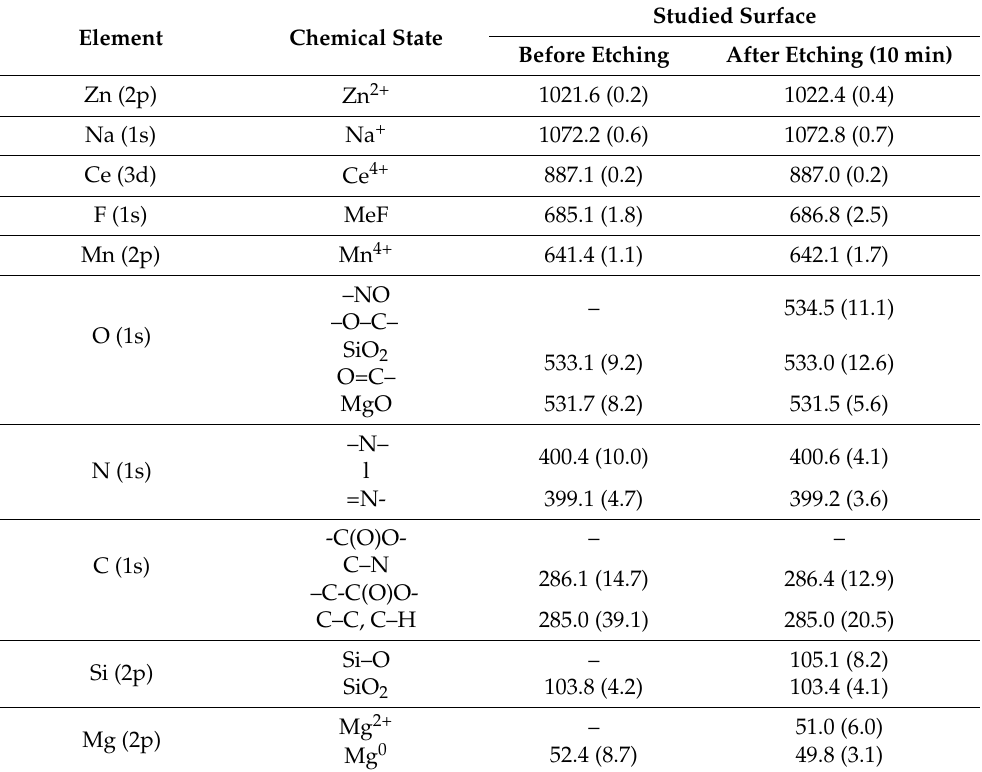
Table 2. Binding energy (eV) and elemental composition (at.%, in parentheses) of the sample’s surface after treatment of a PEO layer with benzotriazole